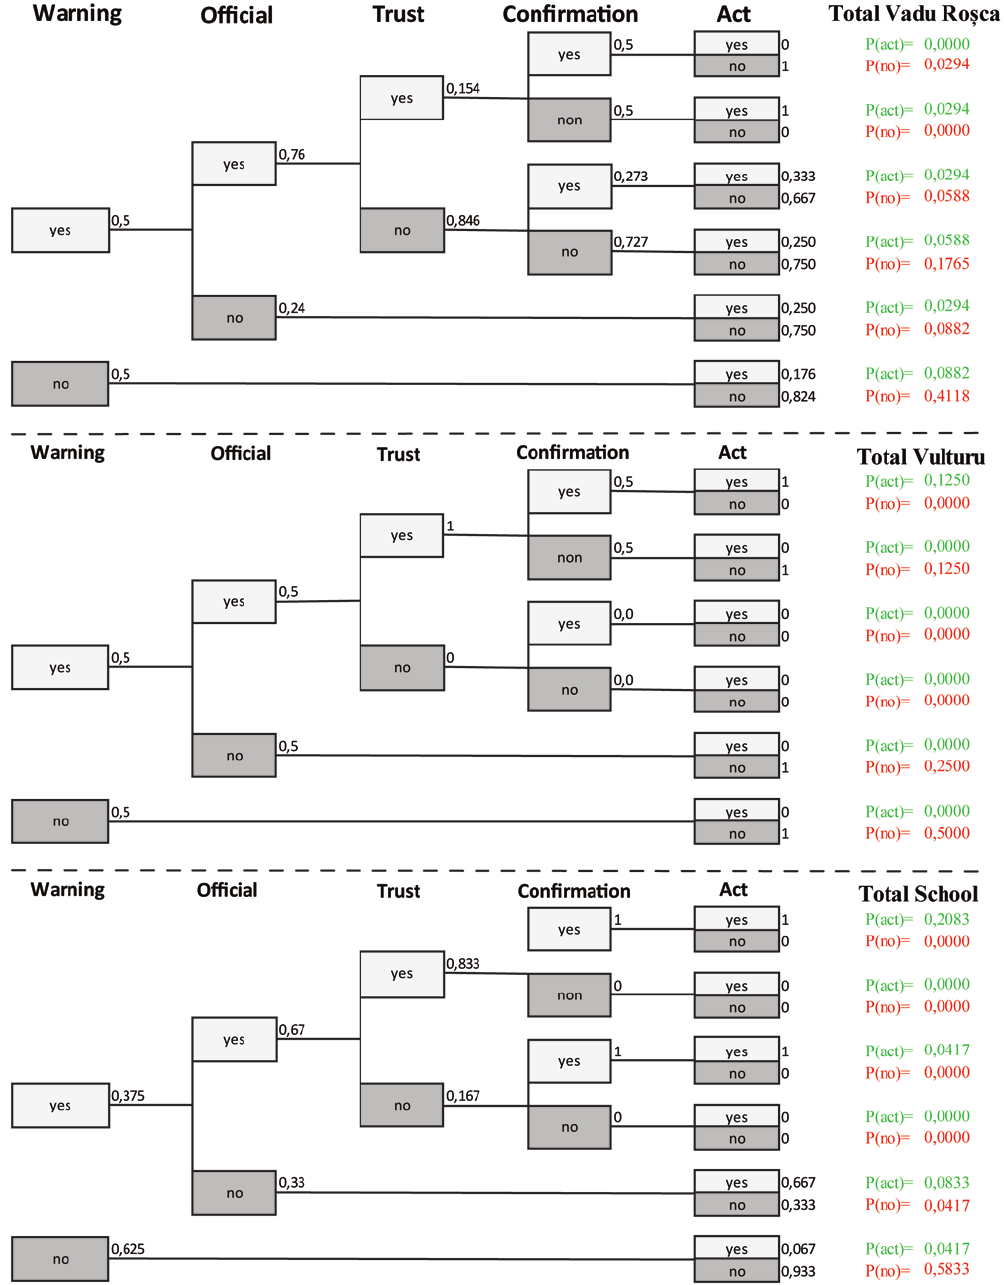
Fig. 4. Detailed results of the questionnaires in Vadu Ros¸ca, Vulturu and at